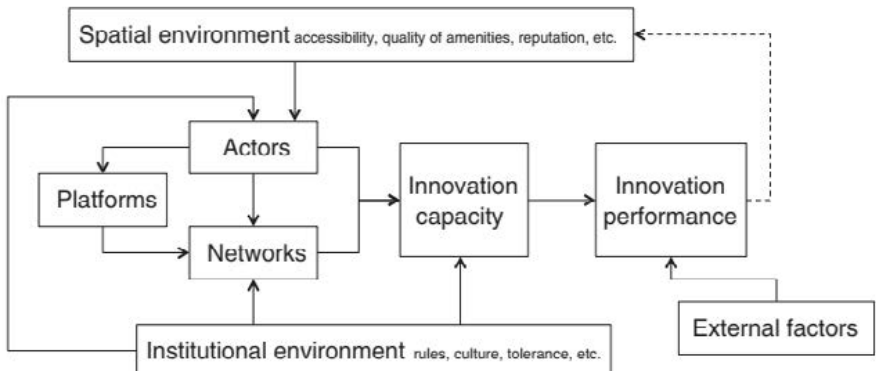
Fig.1: Performance and innovation capacity in the UIS (Van Winden et al ., 2014 )